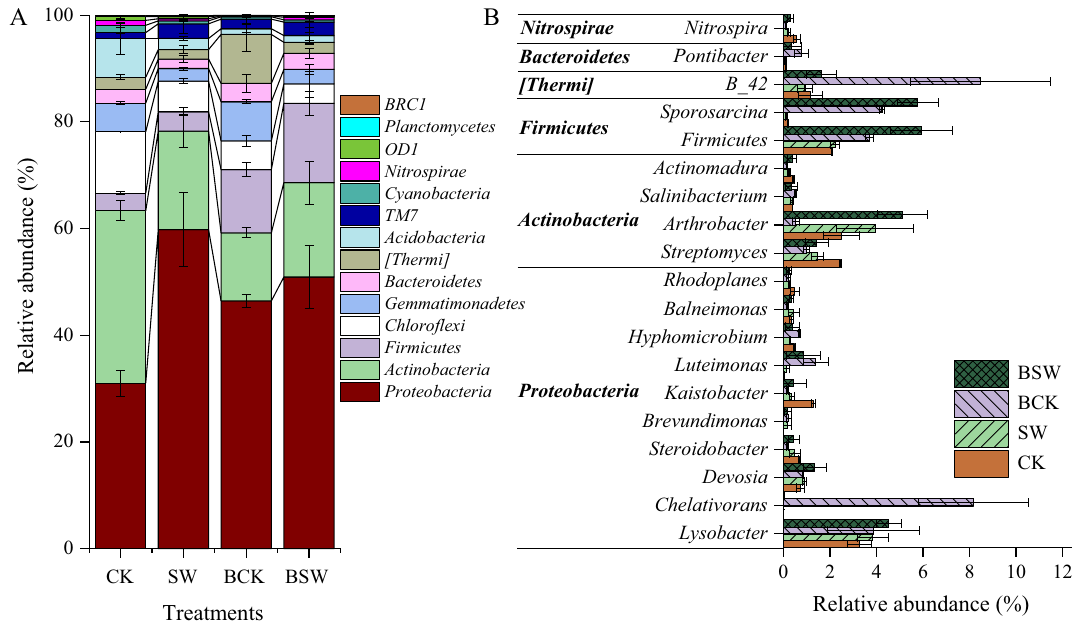
Fig. 5 Relative abundance of bacterial community composition at the phylum ( A ) and genus ( B ) levels. CK: control; SW: soil treated with 1%‑biochar; BCK: soil treated with S. pasteurii ; BSW: soil treated with S. pasteurii and 1%‑biochar. Error bars represent the standard deviation of the means (n =